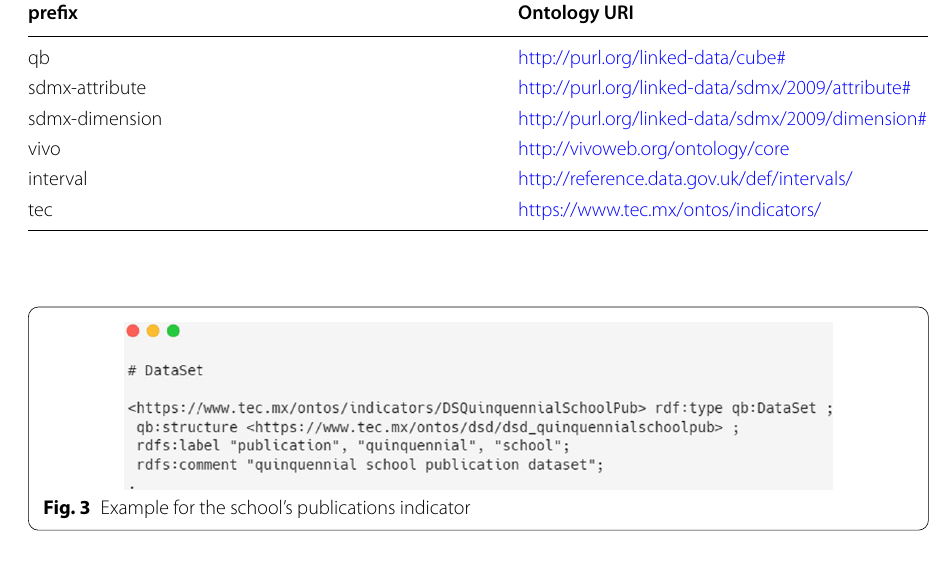
Table 2 Ontologies used for representing scientometric indicators prefix